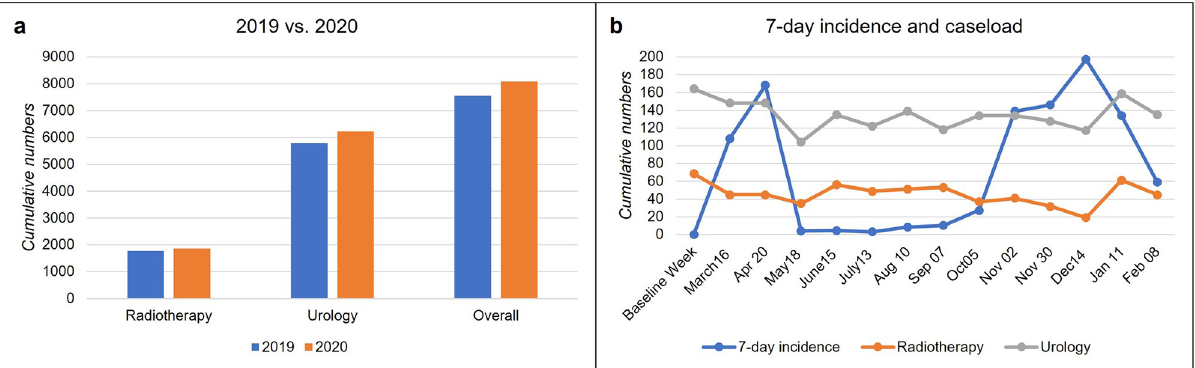
Fig 1. Cumulative numbers of PCa patients. (A) Cumulative numbers of patients undergoing prostate cancer therapy either with radiotherapy or radical prostatectomy in 2019 vs. 2020. (B) Development of patient numbers after the beginning of the pandemic. The blue line demonstrates the 7-day incidence of COVID-19 in the corresponding